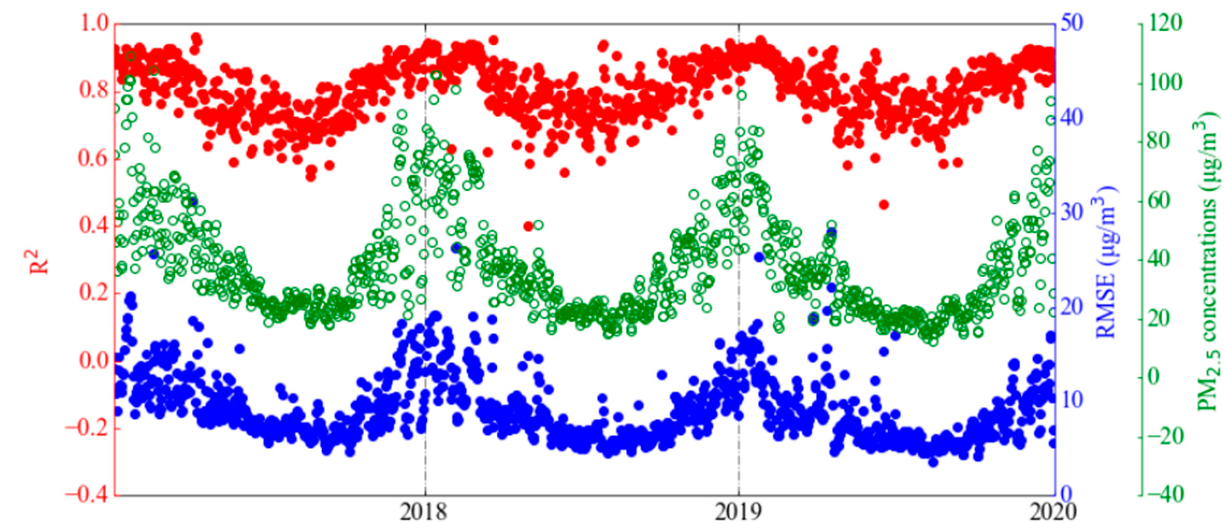
Figure 3. Time series of evaluation results of the daily models and daily averaged in-situ PM 2.5 concentrations from 2018 to 2020. Red and blue points represent R 2 and RMSE, respectively, and green points represent PM 2.5 concentrations.